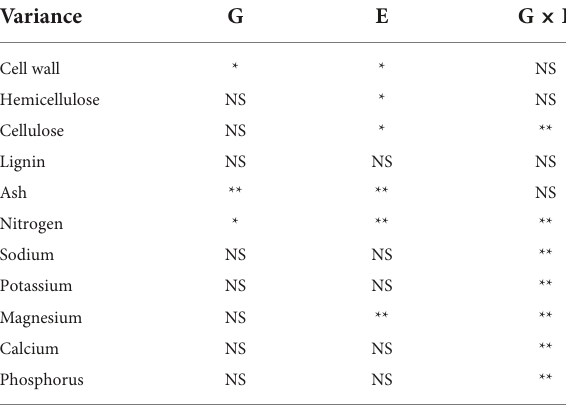
TABLE 3 Significance of effect of genotype (G), location (L), year (Y), genotype × location (G × L) on quality (model II). Variance G E G ×